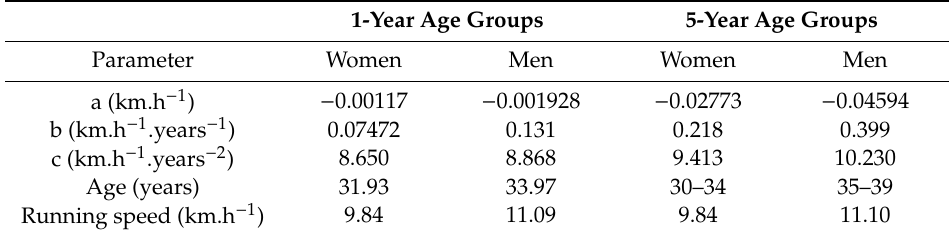
Table 1. Parameters in the second-order polynomial regression running speed (km.h − 1 ) = a + bx + cx 2 , using the running speed of all runners in 1-year age and 5-year age groups by sex.